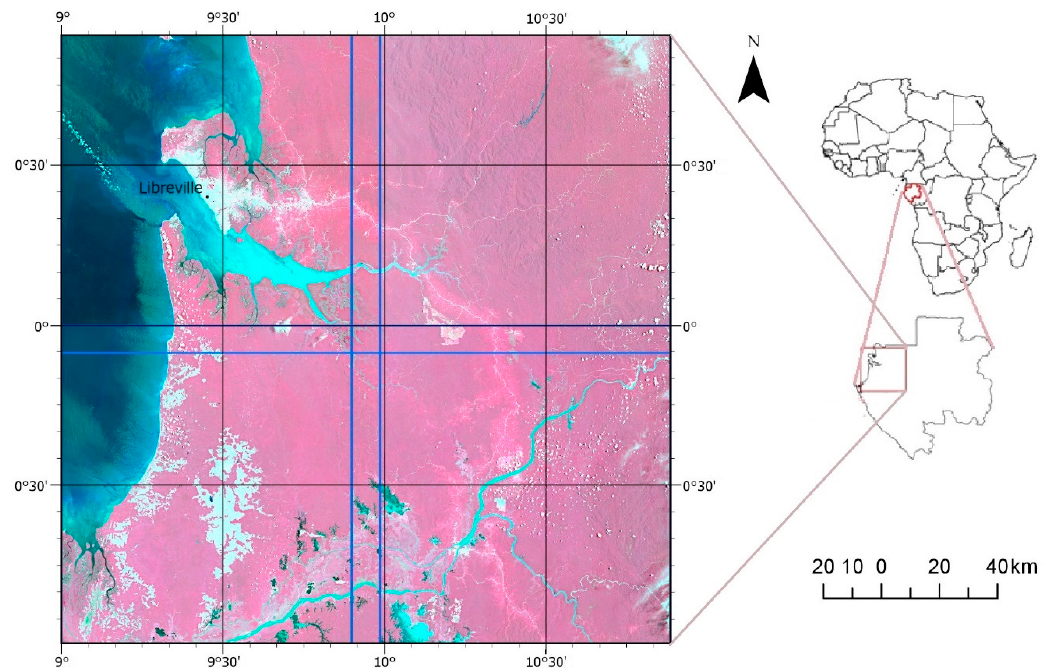
Figure 1. Location of the study site; the study area covers the extent of the four Sentinel-2 scenes presented in the colour composite of bands B8, B4 and B3; the blue lines indicate the extent of the Sentinel-2 granules.